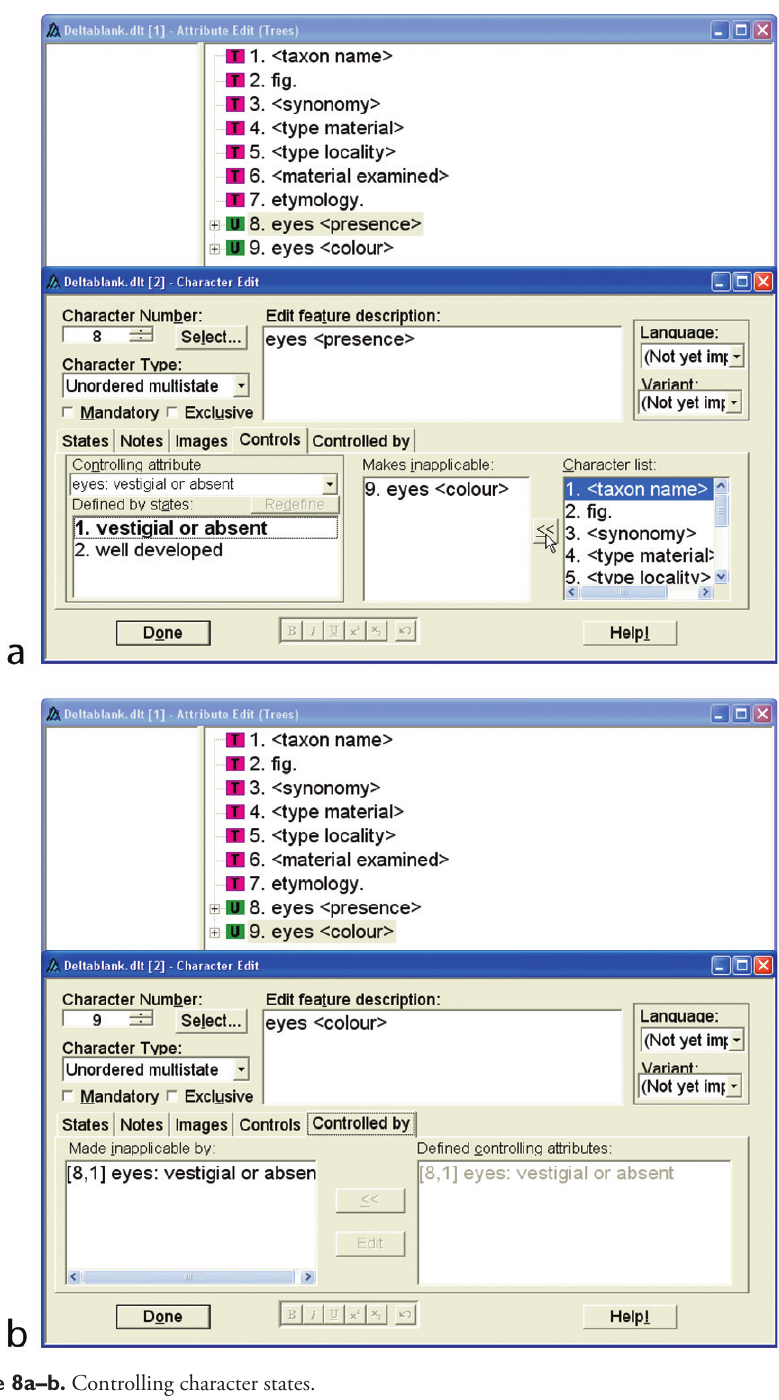
Figure 8a–b. Controlling character